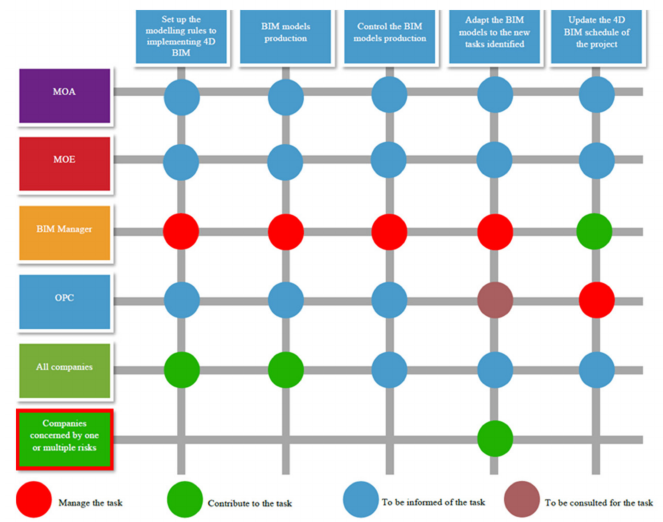
Figure 5. RACI matrix for BIM model production when using 4D BIM.